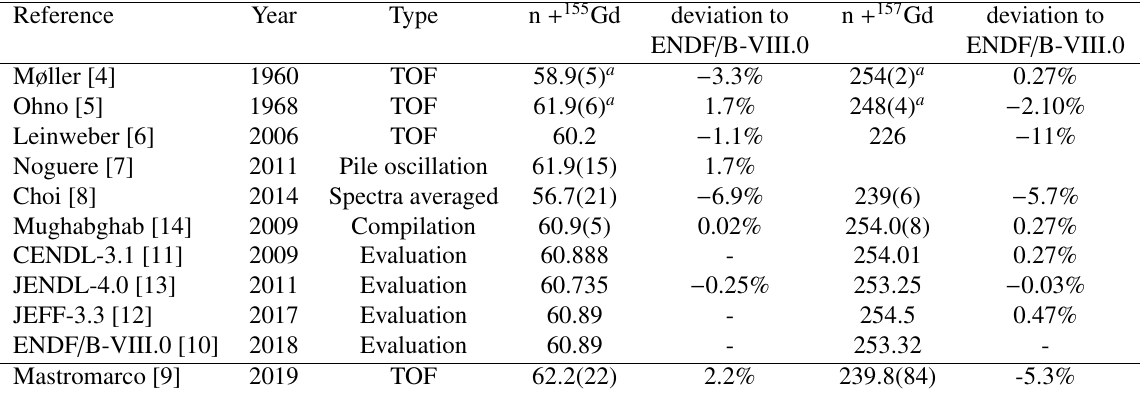
Table 1. 155 Gd and 157 Gd thermal cross sections (in kb) as reported in literature, compilation [14] and evaluations. The results from the present measurement are reported for comparison.